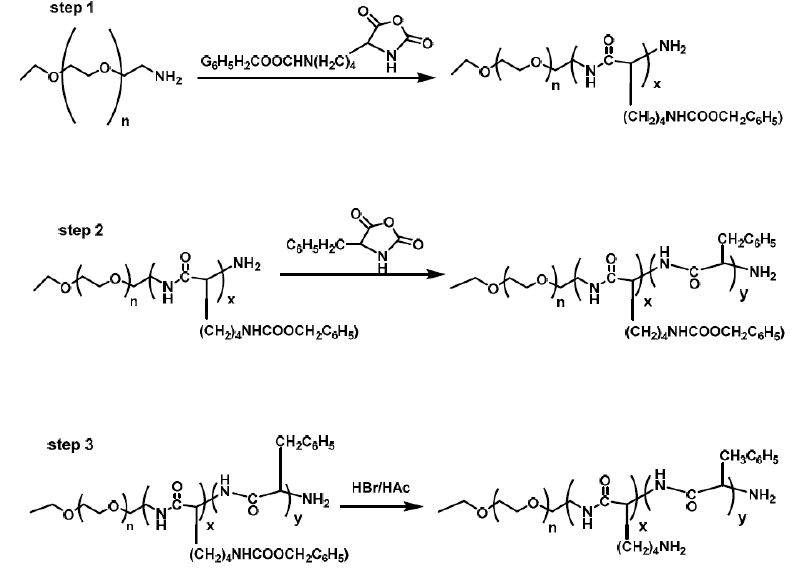
Figure 4. Synthesis of the triblock polypeptide copolymer poly(ethylene glycol)- b -poly( L -lysine)- b - poly( L poly( L -phenylalanine).